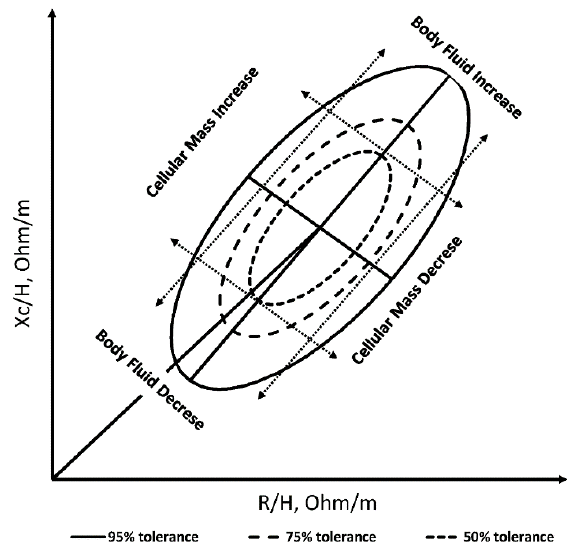
Figure 1. The (R-Xc) graph and tolerance ellipses. Reproduced with permission, Piccoli et al. [17].